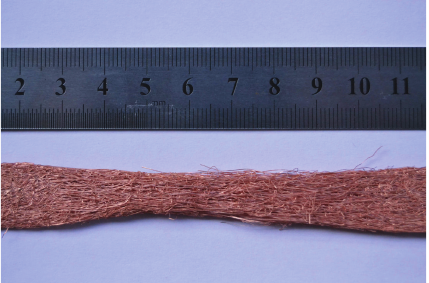
Figure 7: Appearance of the fractured